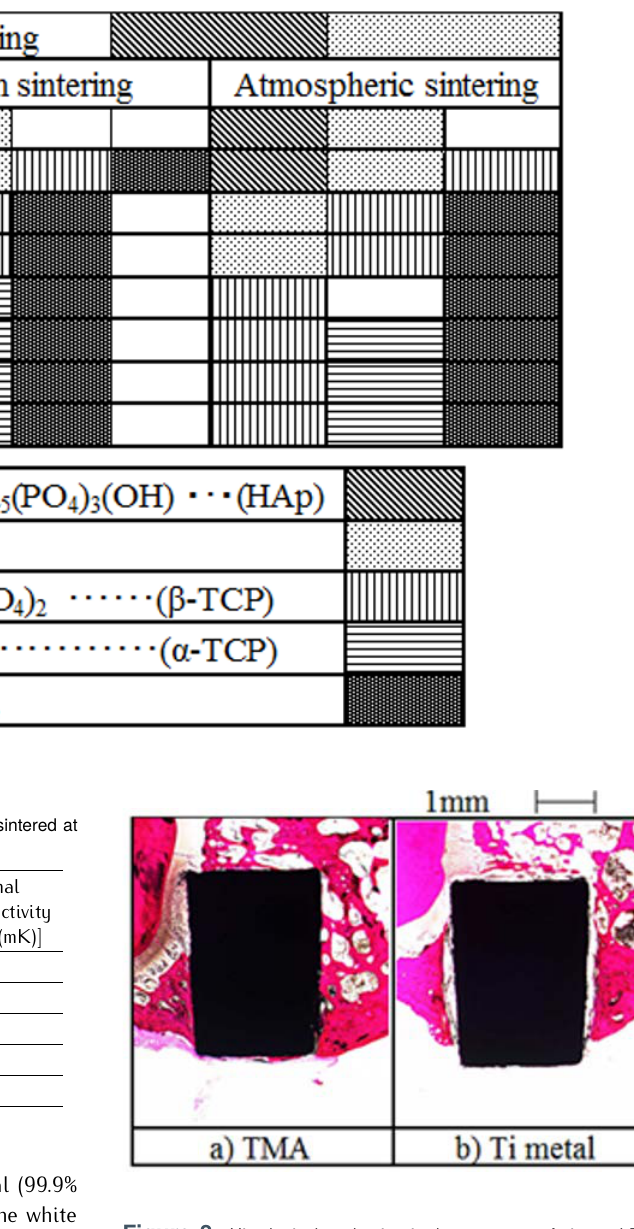
nium and oxygen. The TMA vacuum-sintered bodies were well tolerated in the Figure 3 shows samples of biomaterial parts made from TMA bodies vacuum sintered at 1573 K which were cut using a 3D-modeling machine or a lathe. It was possi- ble to cut the TMA bodies vacuum sintered at 1573 K